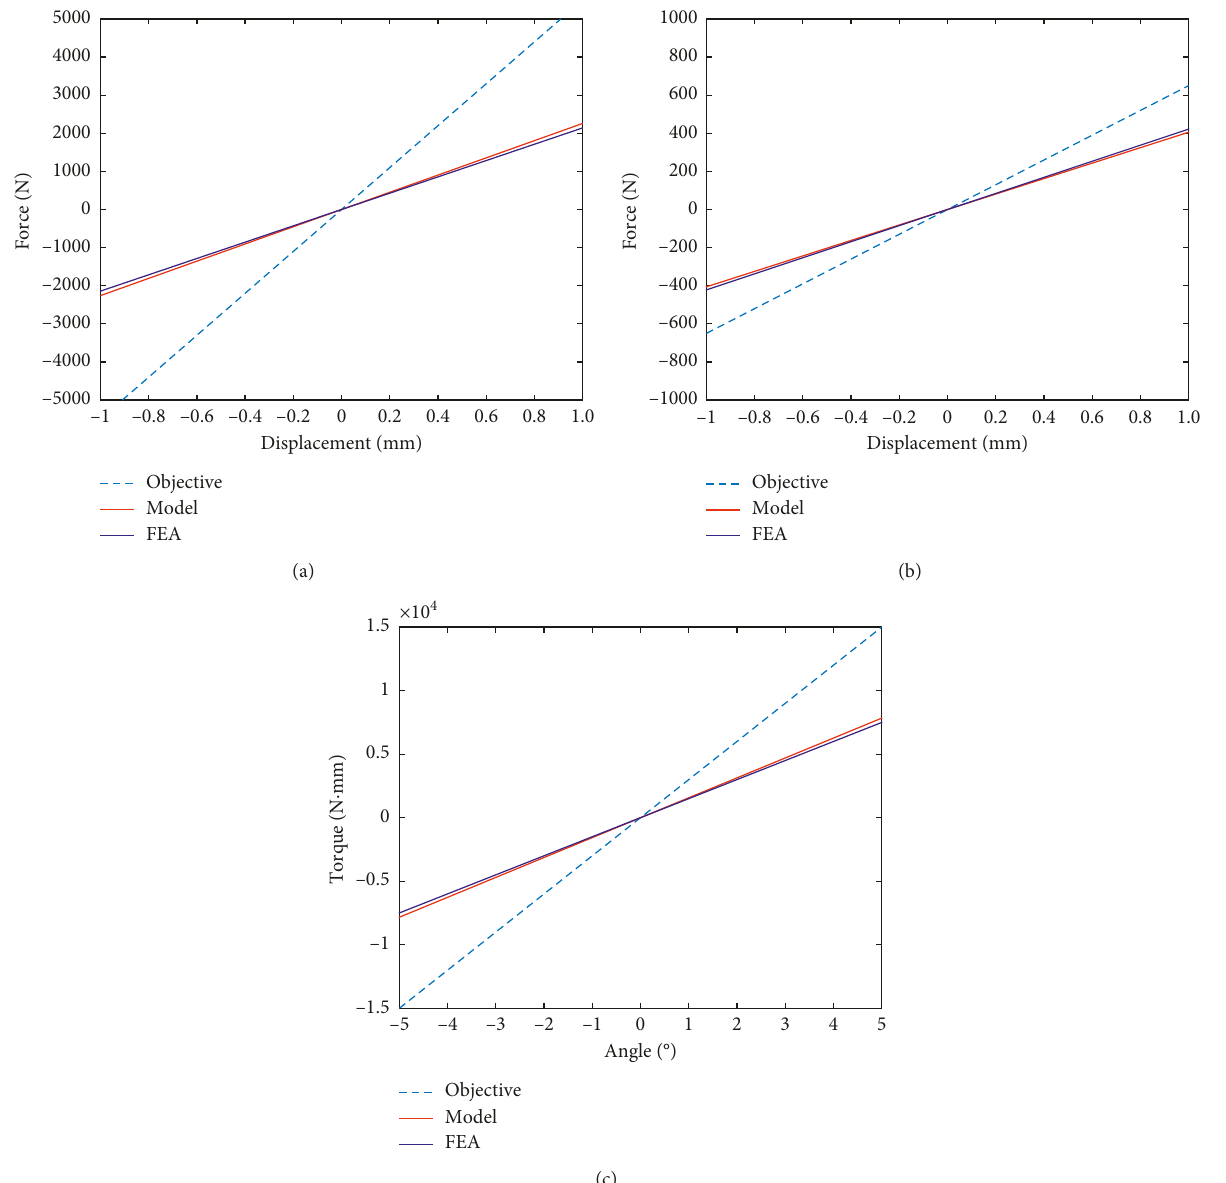
Figure 10: Stiffness requirements, mathematical model, and finite element method of the initial proposed model. (a) Radial stiffness proposed model comparison. (b) Axial stiffness proposed model comparison. (c) Torsional stiffness proposed model